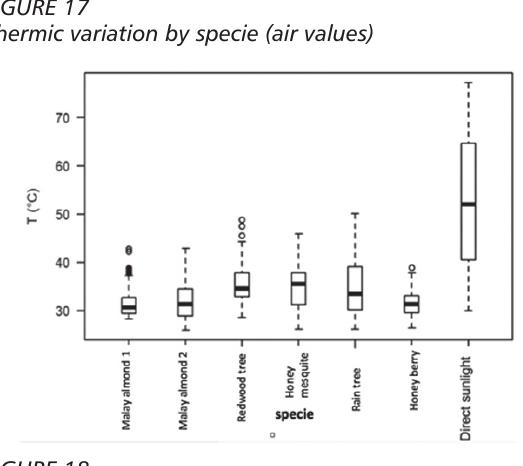
FIGURE 18 Thermic variation by specie (surface values) Total variance (surface values) (41.3 ºC surface under tree and 63.6ºC surface direct sun light) [16]. T-test results indicated that the air temperature under the shadow of Malay almond 1 tree vary significantly (p-value < 0.05) from the air temperature results under the shadows of